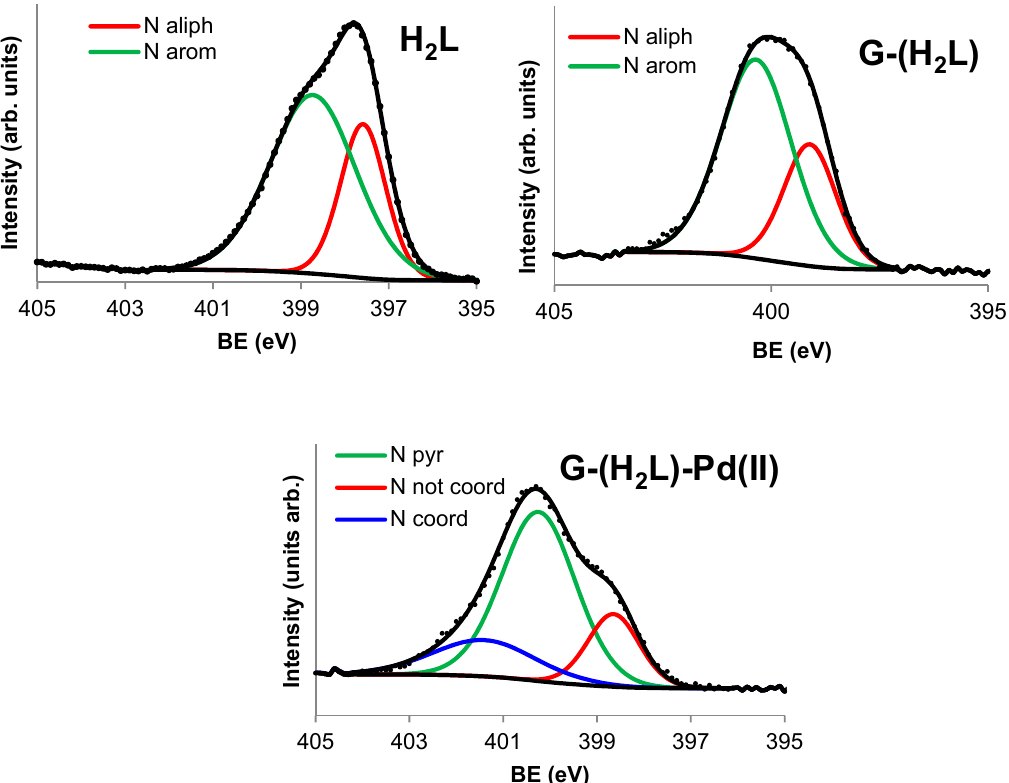
Molecules 2019 , 24 , x FOR PEER REVIEW